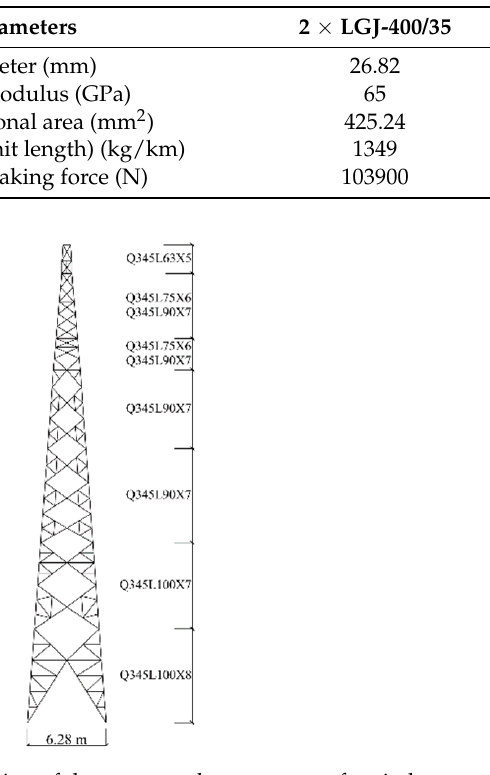
The finite element models of the transmission tower and tower line system were